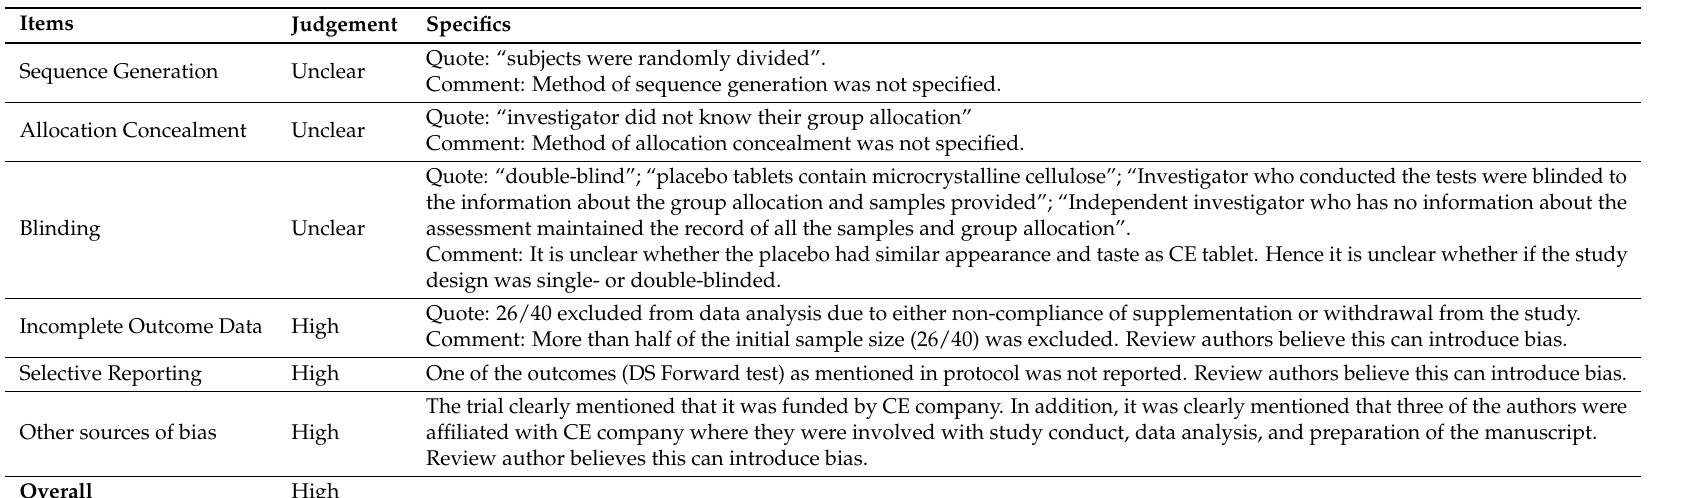
Table A4. Risk of bias assessment of Azhar 2013,